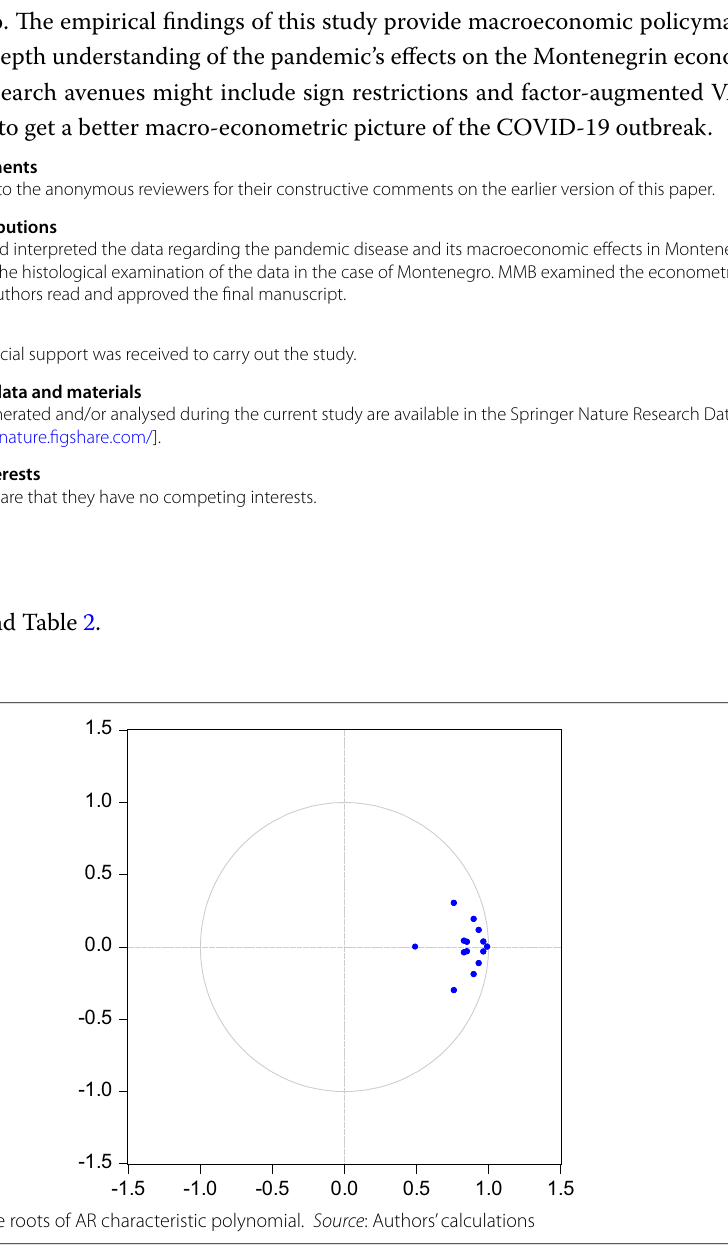
Table 2 VAR (2) residual serial correlation LM. Source : Authors’ calculations Null hypothesis: No serial correlation at lag h